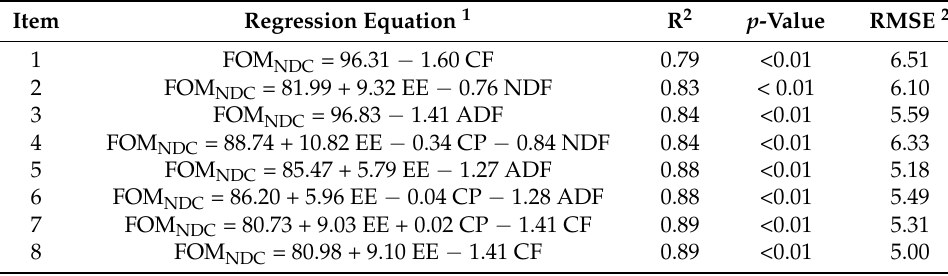
Table 5. Prediction equations between FOM NDC and chemical compositions of roughages.